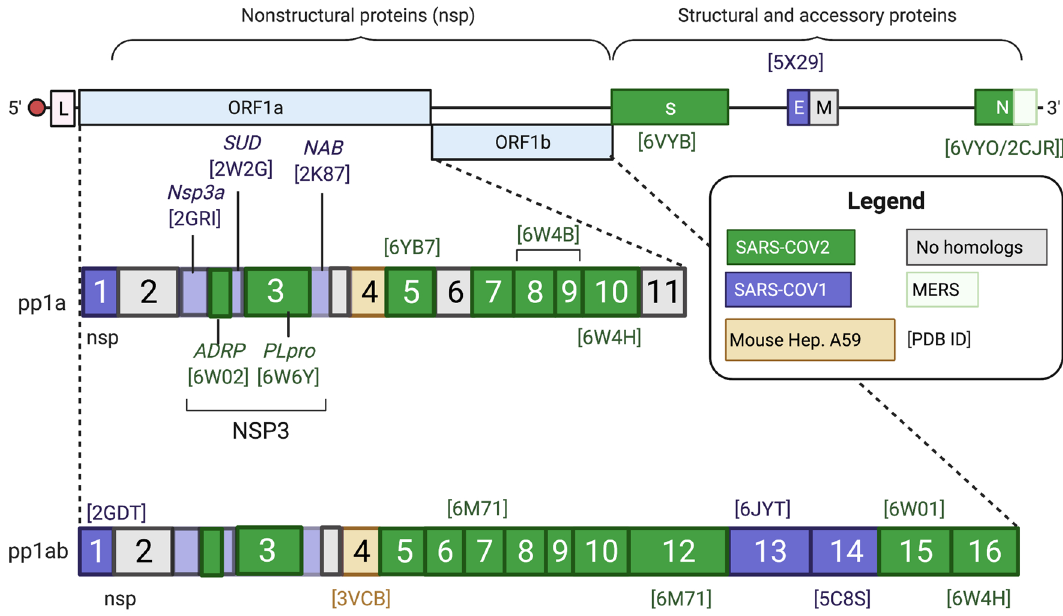
Figure 1. SARS-CoV-2 RNA Genome and Selected PDB Structures. Simplified SARS-CoV-2 RNA genome shows the proteins and PDB structures used for the in-silico drug repurposing screen. i. SARS-CoV-2 structures are in green. In the absence of a SARS-CoV-2 structure, homology models were built based on the closely related SARS-CoV-1 (purple), MERS (green outline), or Mouse Hepatitis A59 (yellow) [E value < 0.001]. Proteins with no SARS-CoV-2 or homologous structures were included in subsequent steps. The [PDB ID] of the chosen structure(s) is included above or below the appropriate gene. Created with